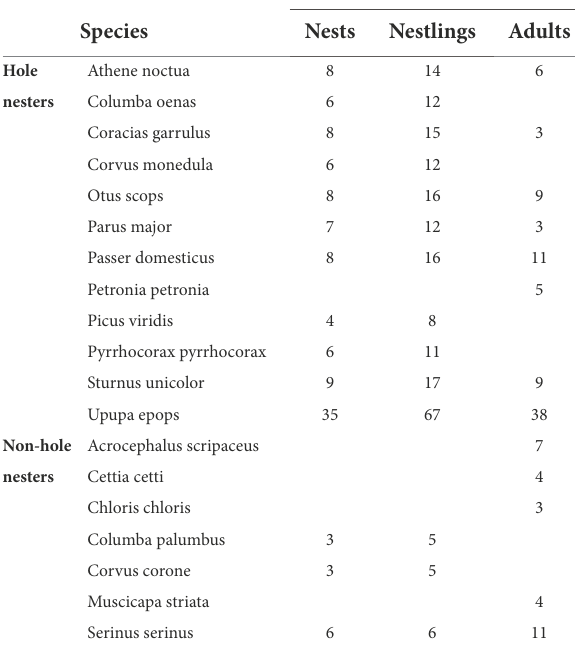
TABLE 1 Sample sizes of adults, nests and nestlings sampled for each species of hole nester and non-hole nester